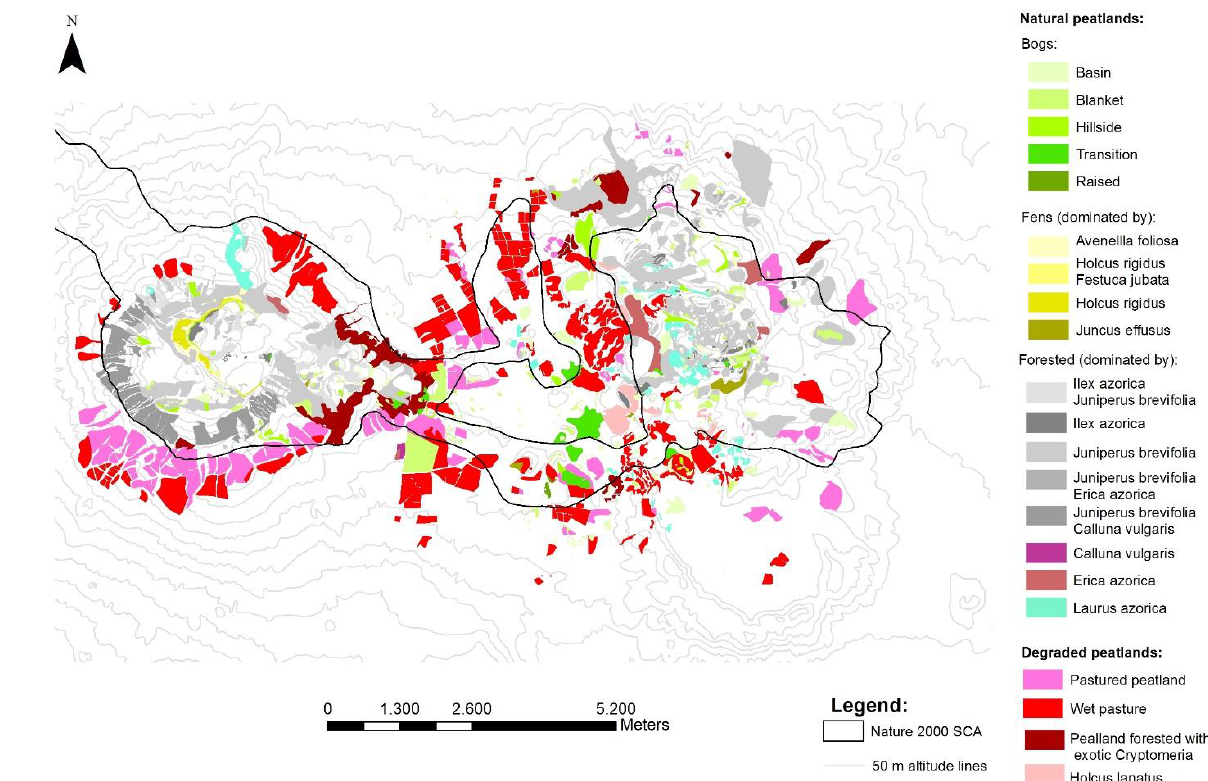
Figure 3. The distribution of peatland on Terceira Island, which is largely coincident with the St. Bárbara / Pico Alto Natura 2000 area (SCA). Natural peatland types identified in this study are distinguished; degraded peatlands are placed in a single group regardless of type. Digital base map: Military Map 1:25000. Projection System: U.T.M. Local Data: Graciosa base SW 1948 Zone 26S. Font: